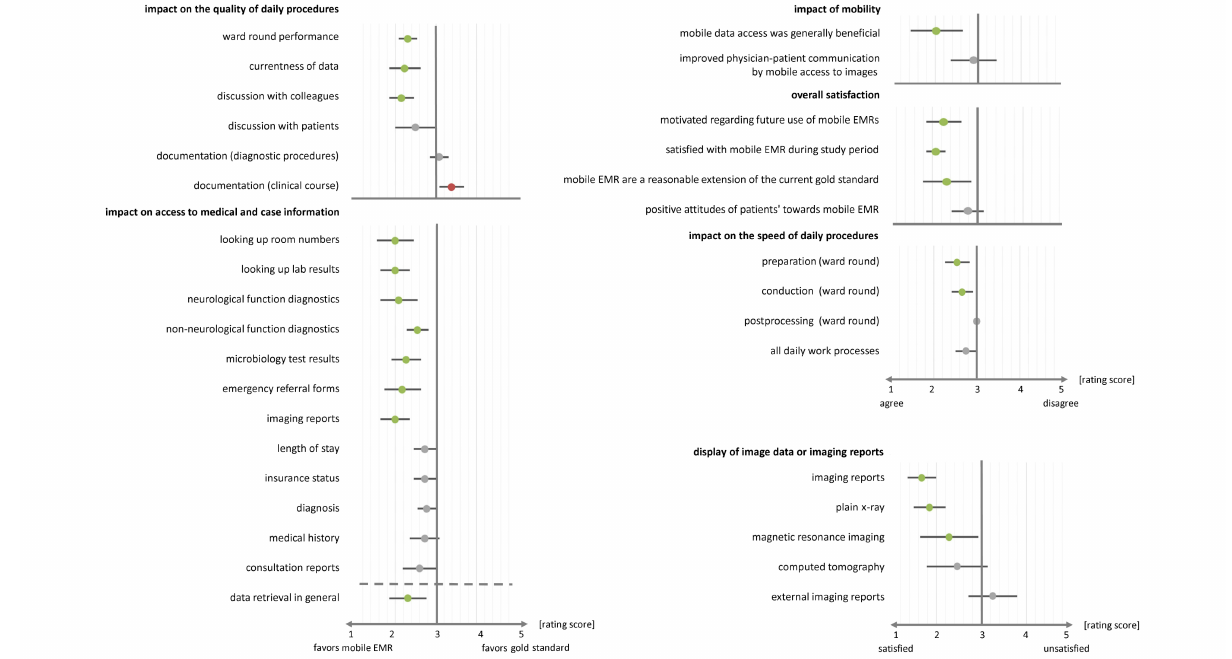
Figure 1. Summary of the survey data representing mean values of participants’ responses (dots) along with their 95% confidence intervals (bars). Colored dots: statistically significant at α =.05; gray dots: nonsignificant result; green dots: improvement through tablet use; red dots: no improvement through tablet